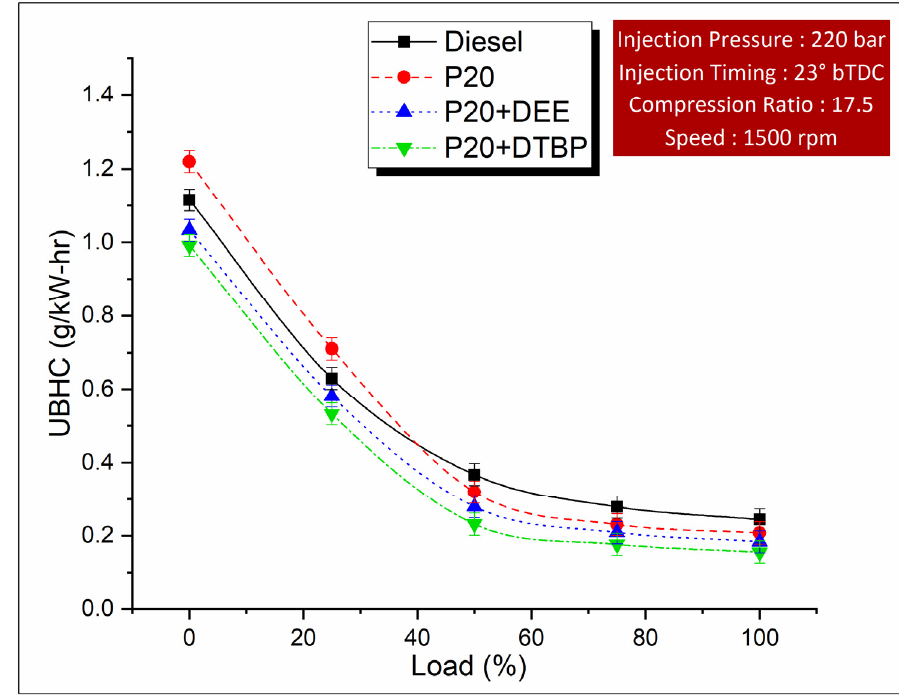
Figure 8. HC variation for test fuel blends at different load condition